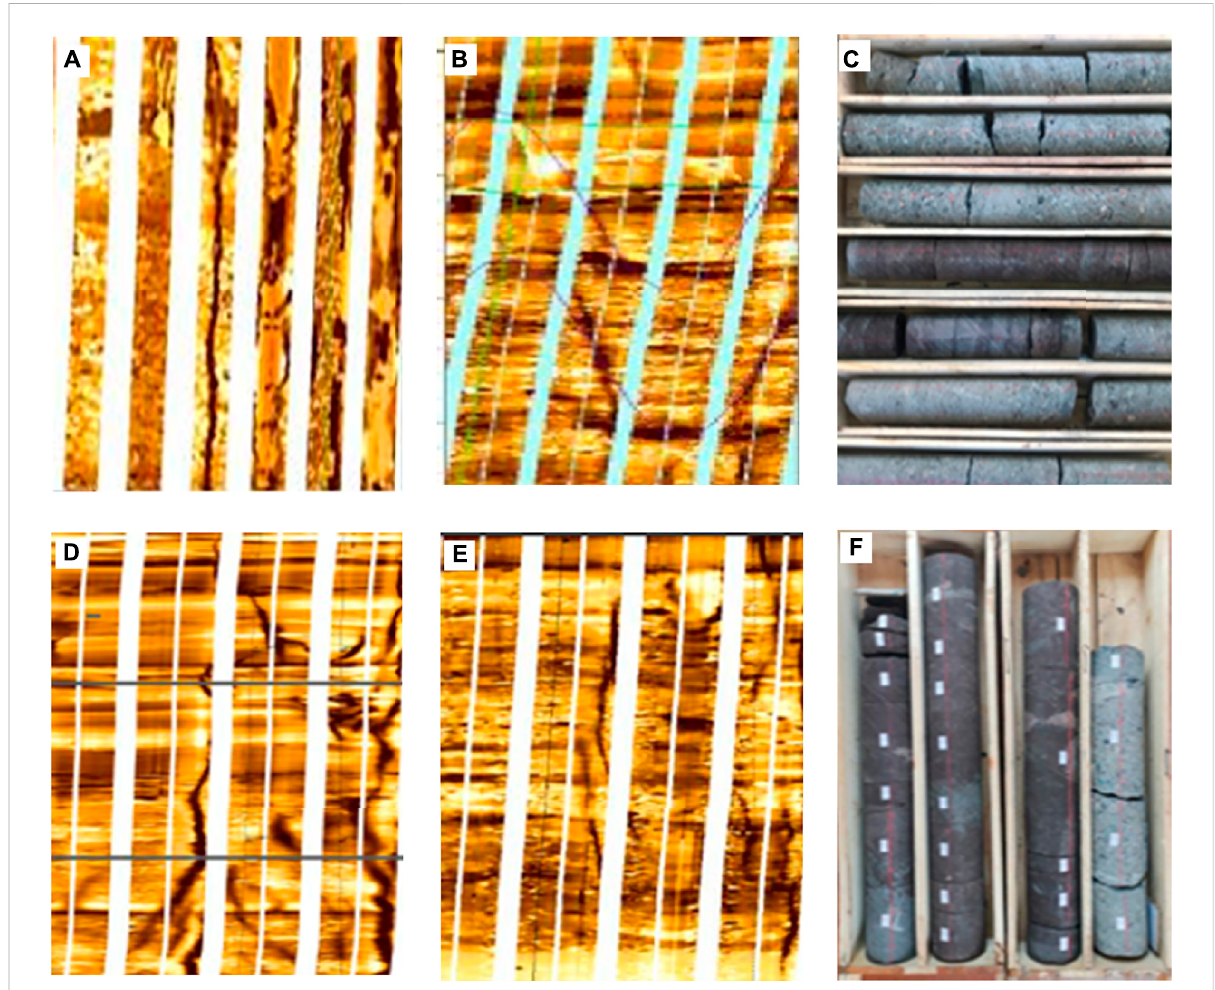
FIGURE 5 Development characteristics of fractures in imaging resistivity and cores. (A) . Glutenite, Dinan 14 well, 4000 m – 4008 m; (B) Glutenite, Dinan 15 well, 3721 m – 3735 m; (C) Core, Dinan 15 well, 3,731.8 m – 3,739.1 m; (D) Glutenite, Dinan 14 well, 4,000 m – 4,008 m; (E) Glutenite, Dinan 15 well, 3,795 m – 3,797 m; (F) Core, Dinan 15 well, 3,796.5 m – 3,799.8